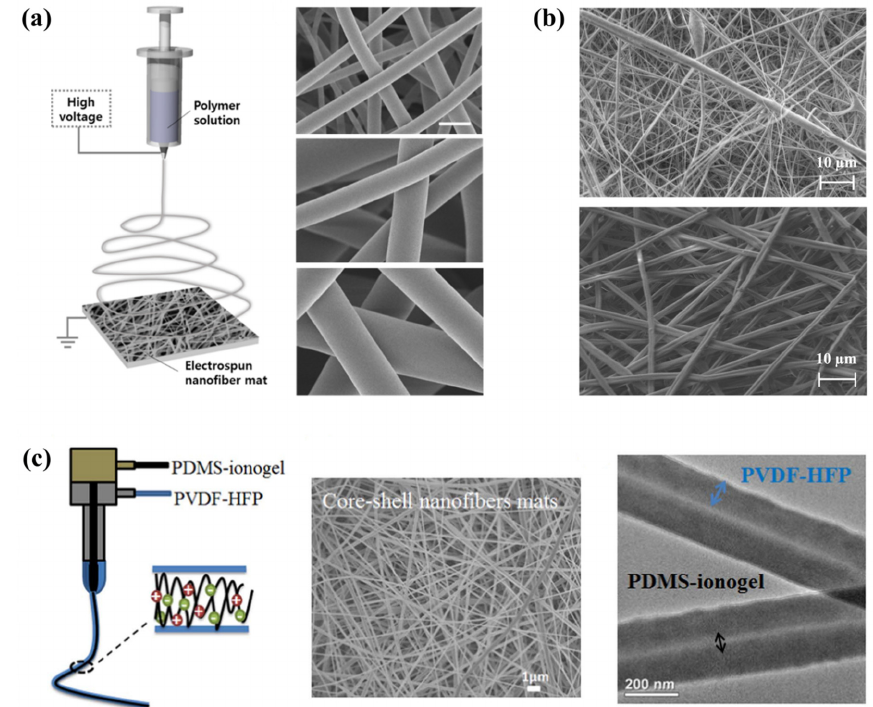
Figure 2. Schematic of electrospinning technique and SEM images of electrospun NFs. ( a ) Electrospun PVDF-TrFE NFs at different solution concentrations of 14, 18, and 22 w/v % from the top to bottom of images. Reproduced with permission from [90] , Copyright (2016), American Chemical Society. ( b ) Electrospun NFs of PVDF and PVP. Reproduced with permission from [113] , Copyright (2018), Elsevier. ( c ) Schematic diagram of core-shell electrospinning technique and SEM images of NFs. Reproduced with permission from [108], Copyright (2018),